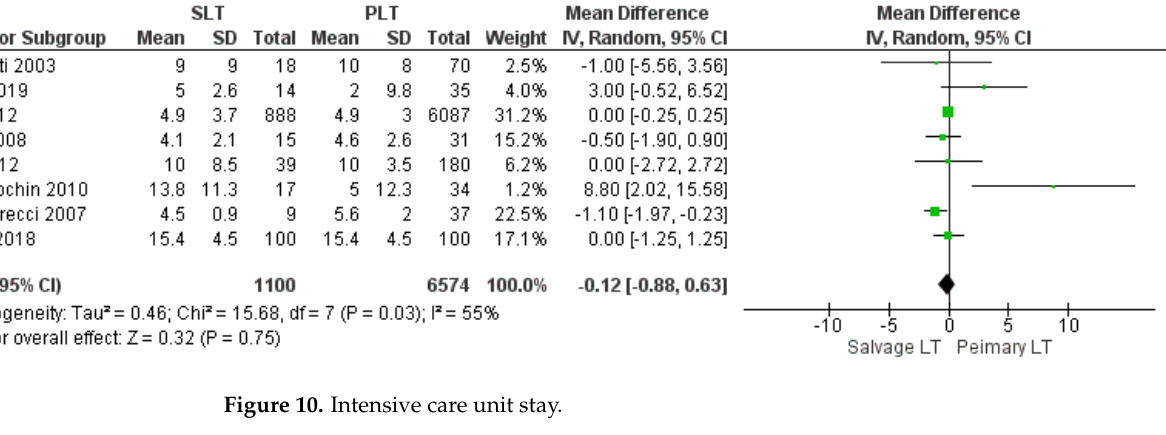
Figure 11. Length of hospital stay. 3.3.4. Overall Vascular Complication The rate of vascular complications was evaluated by 12 studies. The vascular com- plications rate was similar between SLT and PLT: 4.68% (55/1176) and 3.48% (258/7404), respectively. The meta-analysis revealed a statistically significant difference (OR 1.37, (95% CI 1.01, 1.86) p = 0.04), as shown in Figure 12.